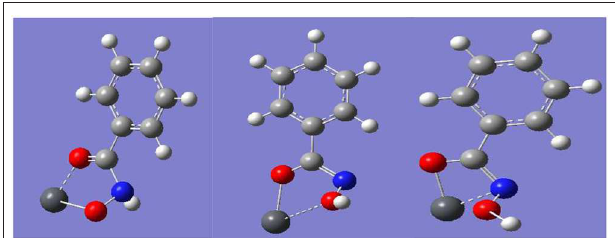
FIGURE 6 | The three possible combinations of a single lead ion and a single BHA.